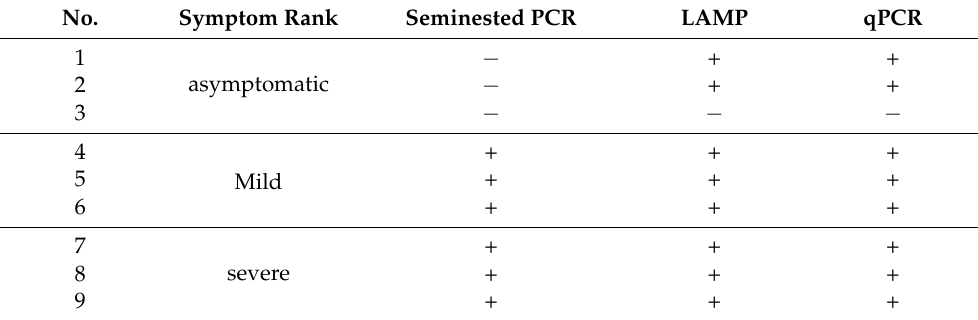
Figure 10. Field-collected hybrid bamboos samples classified as asymptomatic, mild, and severe according to the degree of incidence of different grades. ( A ) asymptomatic samples; ( B ) mild samples; ( C ) severe samples. Table 4. The results of field-collected samples for detecting A. phaeospermum.